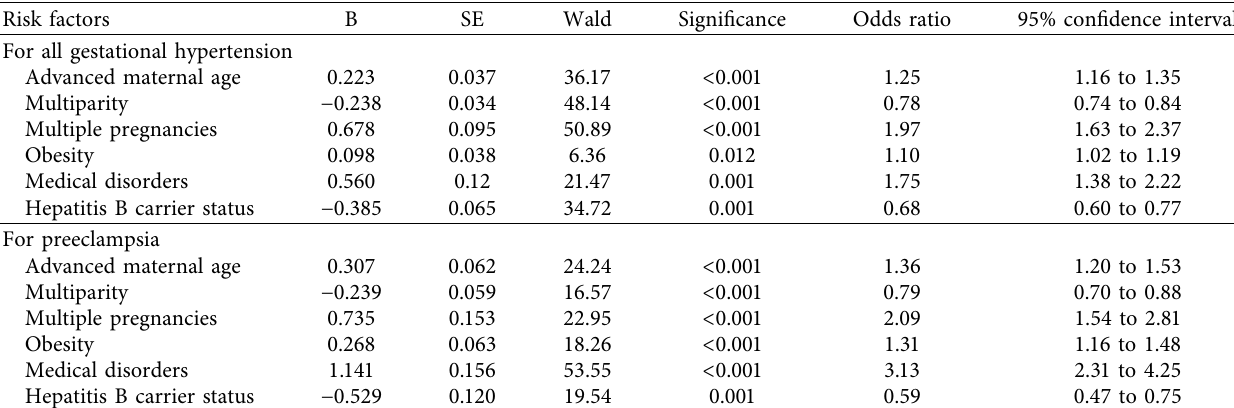
Table 5: Logistic regression of risk factors associated with the presence or absence of gestational hypertensive disorders and preeclampsia. Risk